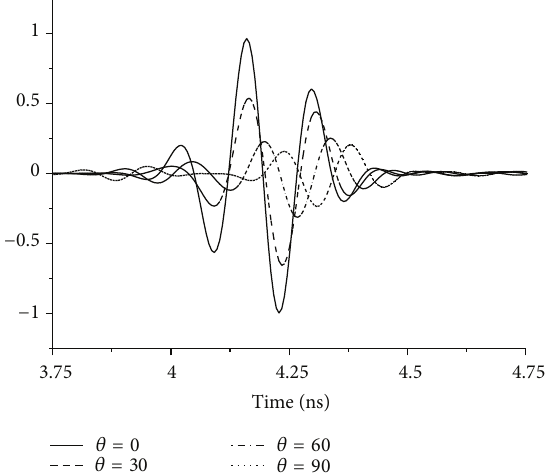
Figure 5: Normalized radiation signal waveform in H-plane ( 𝜑 = 90 ∘